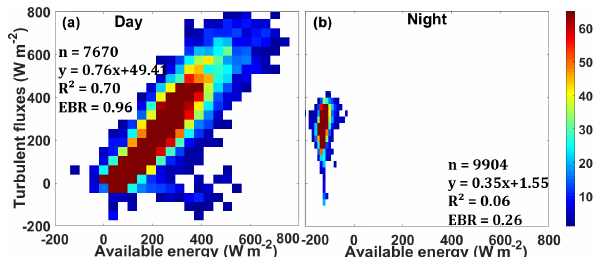
Figure 4. Turbulent fluxes correlation to available energy for day- time (a) and night-time (b) , using the full (2000–2014) 15-year available data series. The colour bars represent the count of EBR values.